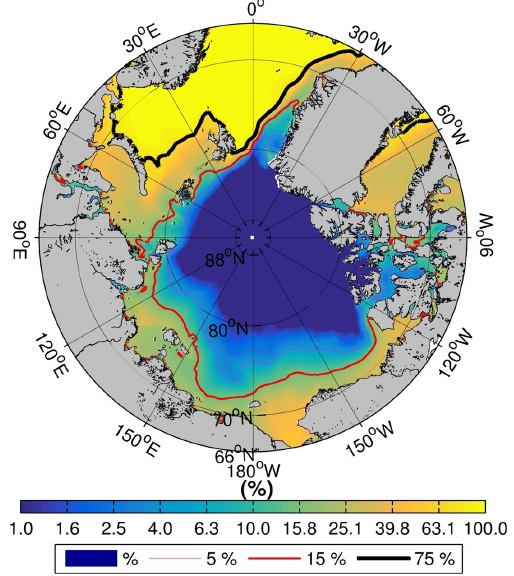
Figure C1. Percentage of ice-free time. Contours represent the 5th (thin purple line), 15th (medium red line), and 75th percentiles (thick black